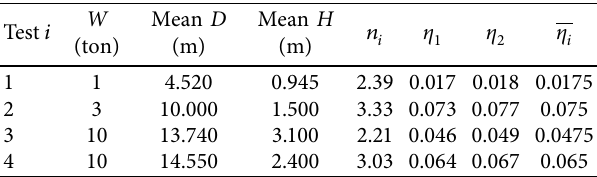
Table 10: Calculated results of energy conversion coefficient for different